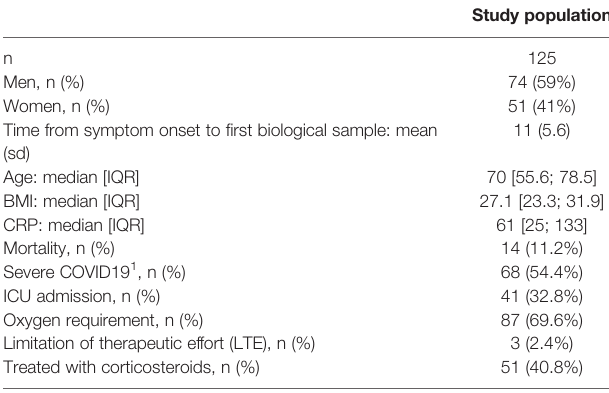
TABLE 3 | Description of the